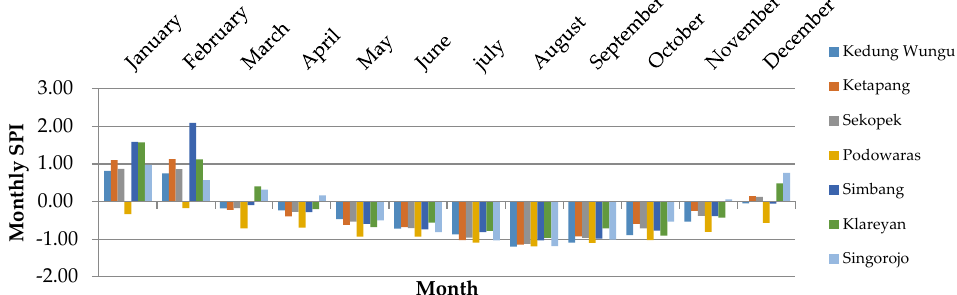
Figure 5. Monthly SPI at the driest rainfall stations.